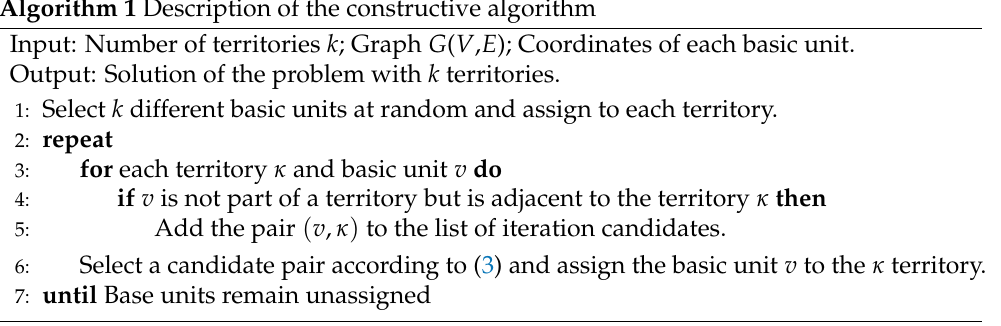
Algorithm 1 Description of the constructive